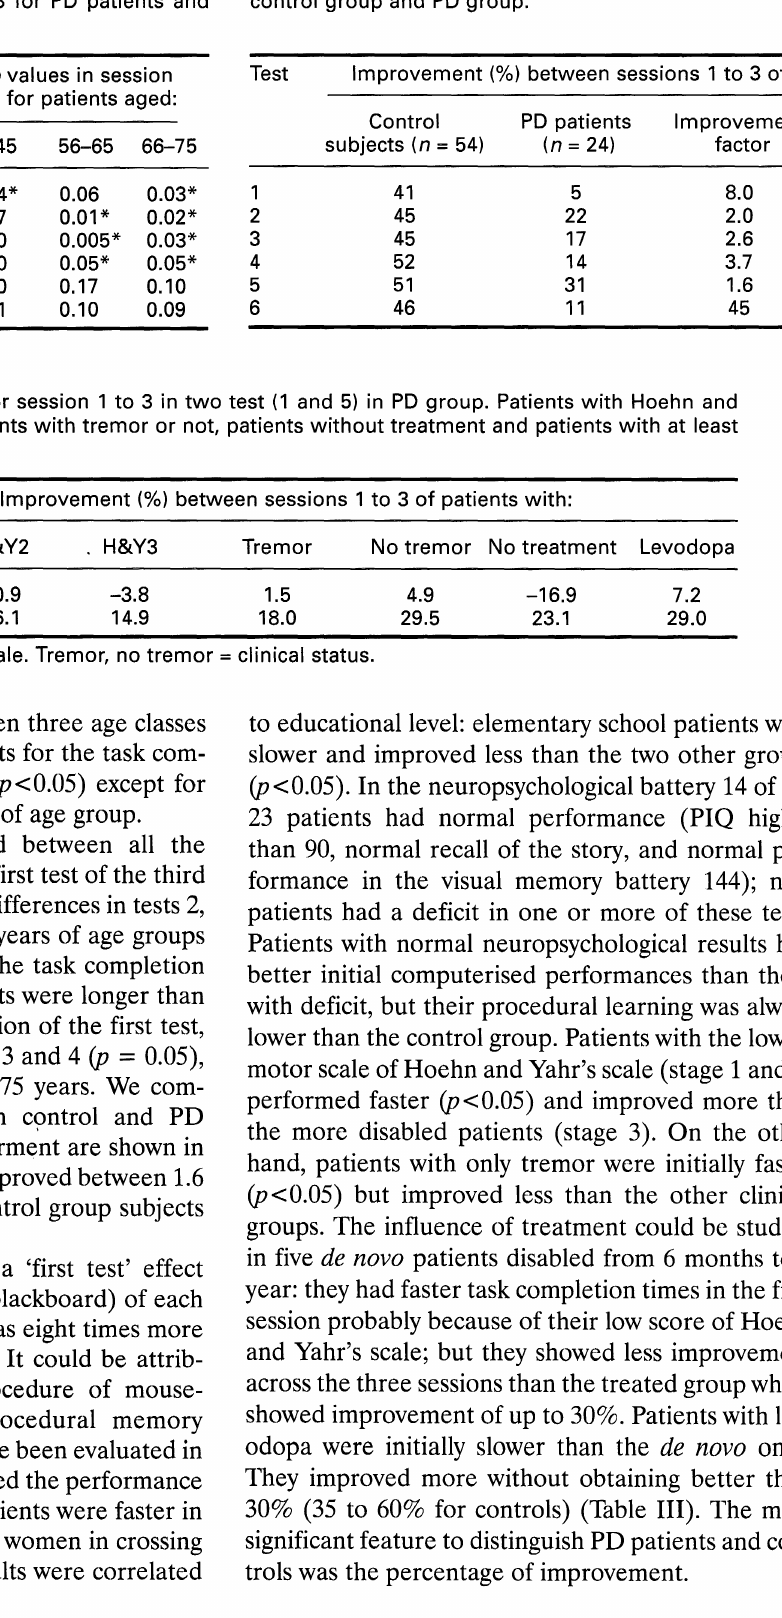
Table II: the PD patients group improved between 1.6 and 4.5 times less than the 54 control group subjects matched for